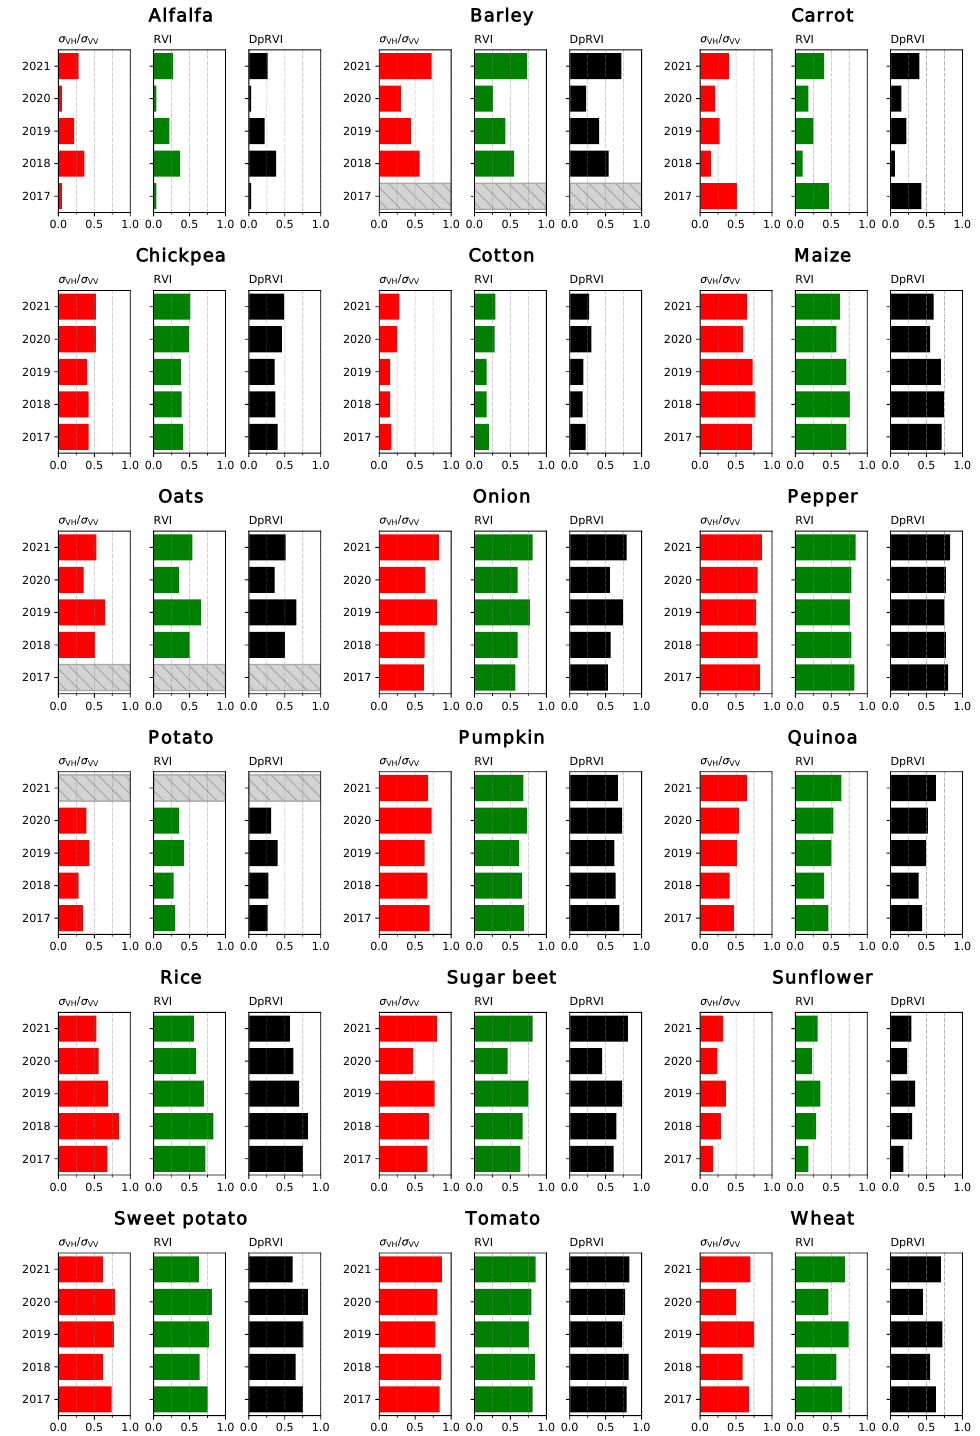
Figure 8. Coefficient of determination ( R 2 ) for the linear regressions between different radar VI and NDVI, considering the complete time series. Years without data for a specific crop type are identified with a striped